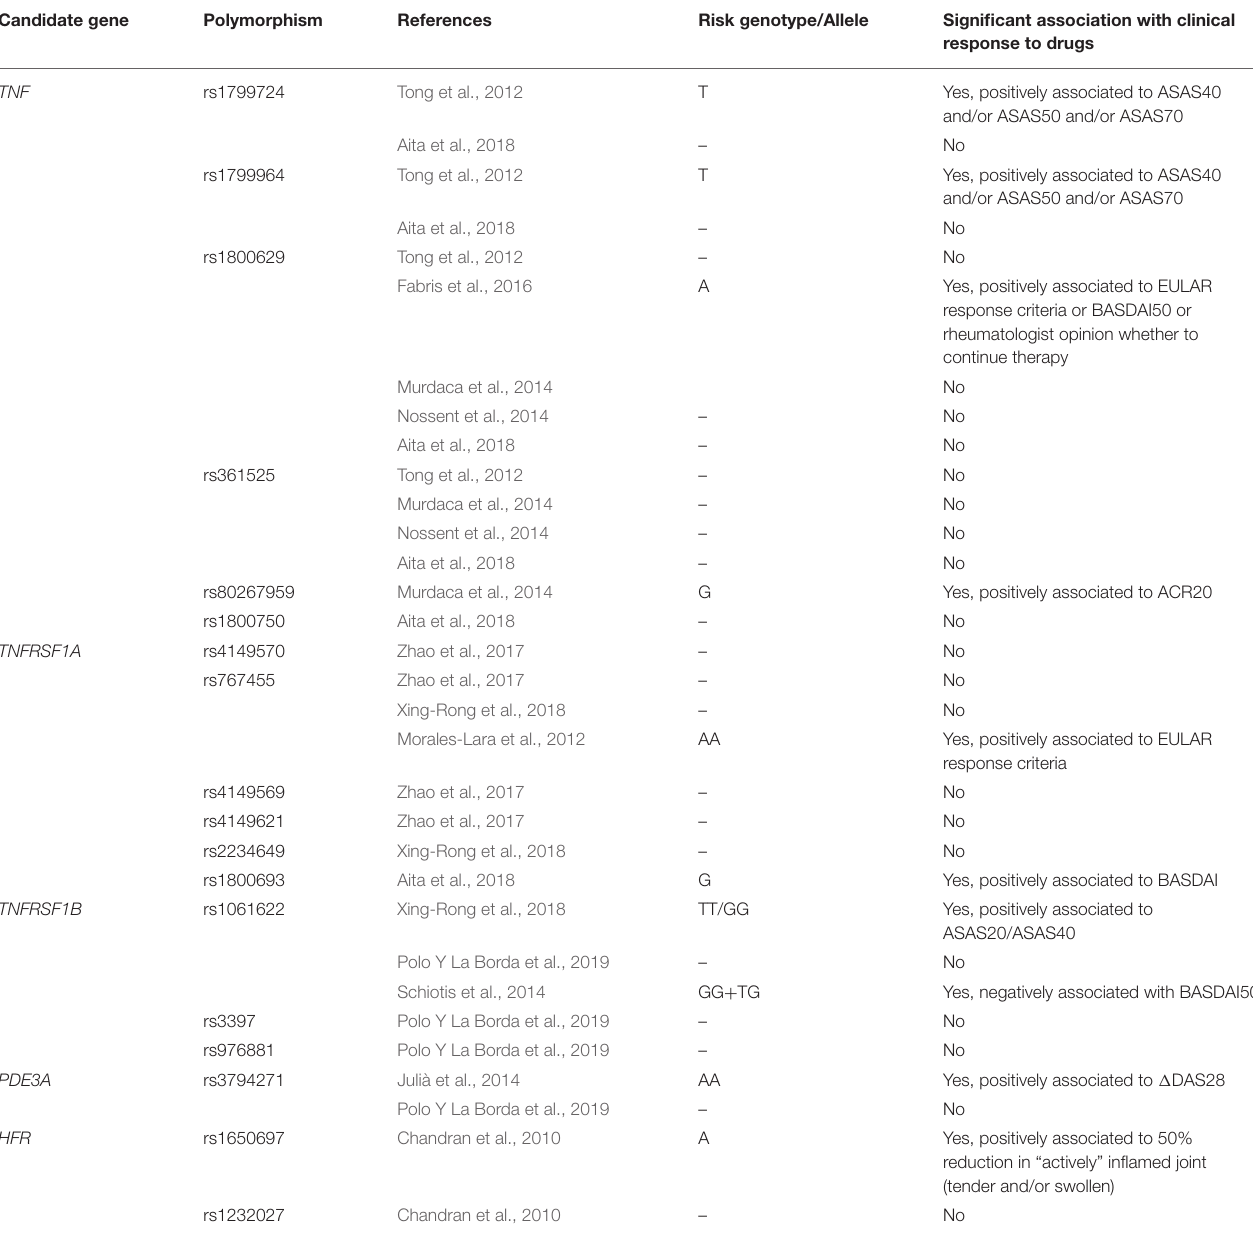
TABLE 4 | Synthesis of genes that have been studied in relation to treatment response in spondyloarthritis, and summary of results. Candidate